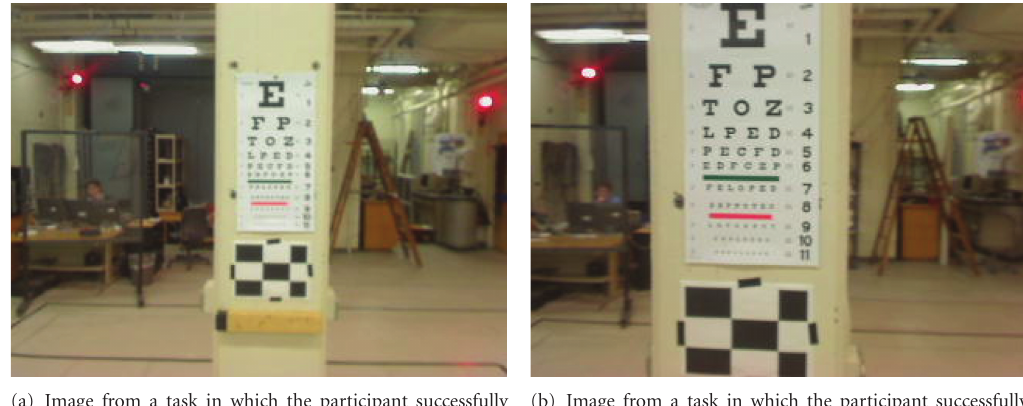
Figure 11: Images obtained by the MAV’s camera that participants viewed while trying to read a line of the eye chart.